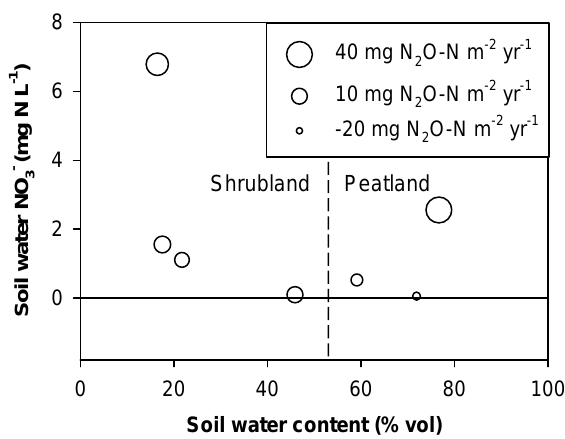
Fig. 5. Size of annual N 2 O flux plotted against mean annual soil water content and nitrate concentration in soil water. Data derive from control plots at seven sites that are divided into shrublands and peatlands by the dashed